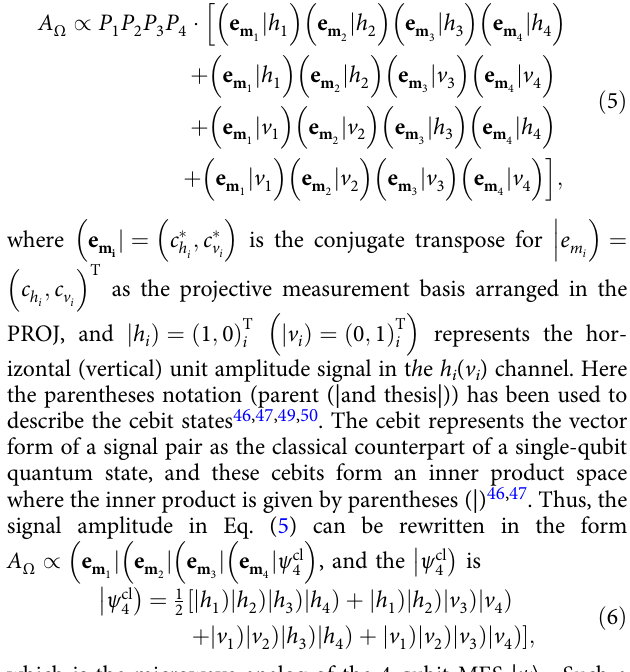
(cid:5) (cid:6) (cid:5) in the DSP module. All eight signals in the channels 4 ¼ P ¼ P ð i ¼ (details are shown in Methods). By assuming P h i v i i 1 ; 2 ; 3 ; 4 Þ under the far- fi eld approximation condition, the corresponding complex amplitude A Ω of the fi nal FFT- fi ltered